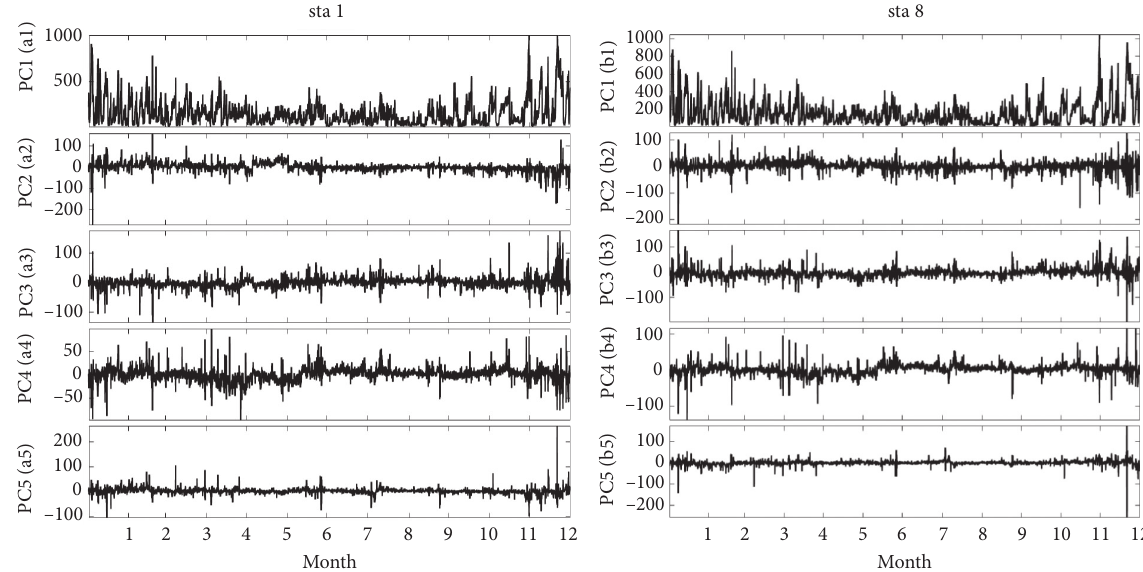
Figure 3: Station 1 (a1–a5) and station 8 (b1–b5) temporal variation in EOF